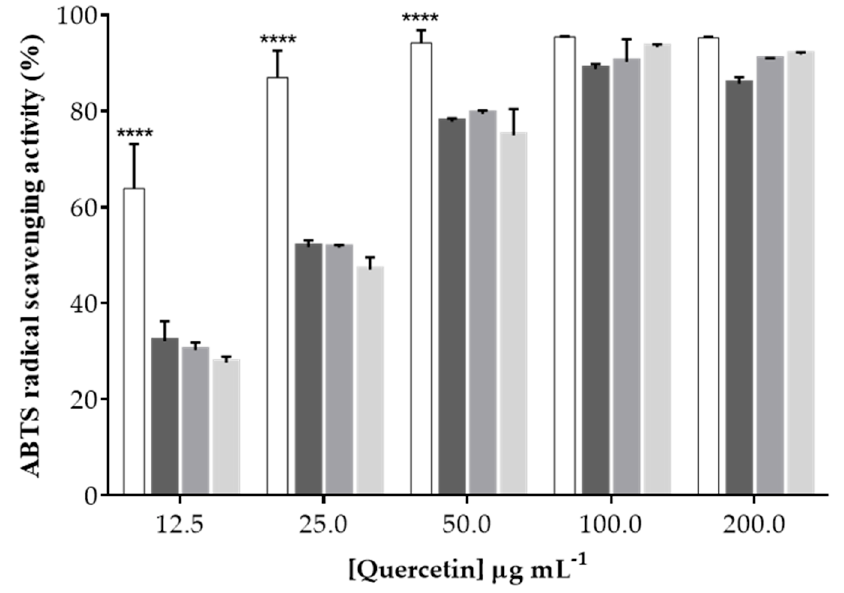
Figure 4. 2,2'-Azino-bis(3-ethylbenzothiazoline-6-sulfonic acid) (ABTS) radical scavenging percentage of free quercetin (white bars) and quercetin-loaded nanoparticles (1F/1C, dark-gray bars; 3F/1C, gray bars; 5F/1C, light-gray bars). Data points correspond to means ± standard deviation for n = 3 replicates; **** p < 0.0001.